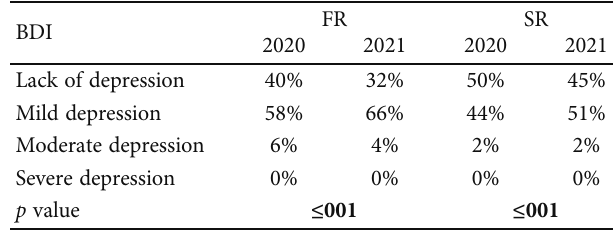
Table 1: BDI results ( N = 300